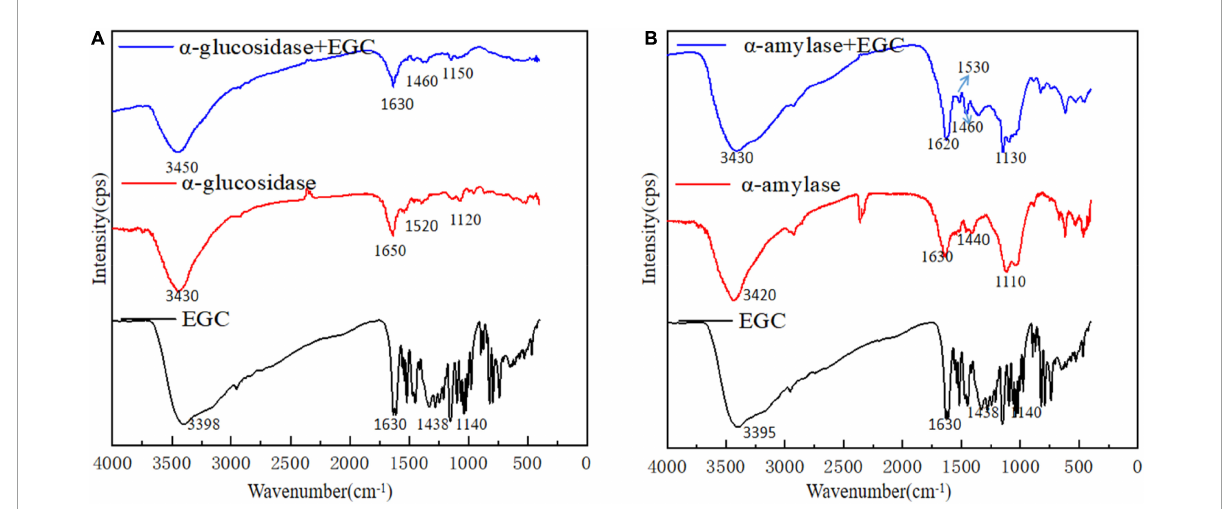
FIGURE4 Fourier transform infrared (FTIR) spectra of different samples [ A : epigallocatechin (EGC), α -glucosidase, α -glucosidase + EGC, B : EGC, α -amylase, α -amylase + EGC].